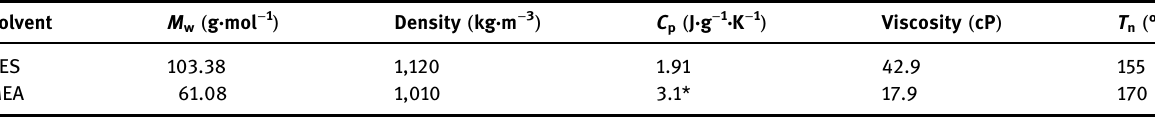
Table A1: physical properties of DES and